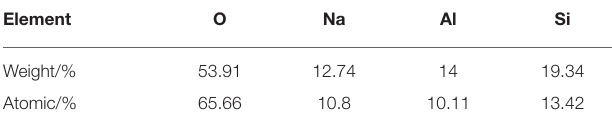
TABLE 3 | Elemental analysis of zeolite X